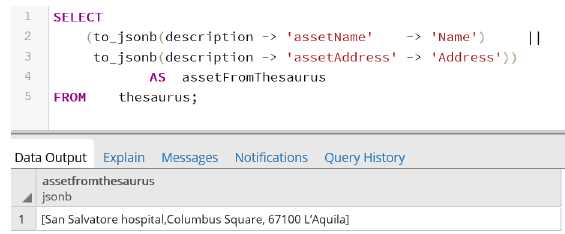
Figure 12. The (JSONB) value about the hospital of L’Aquila.